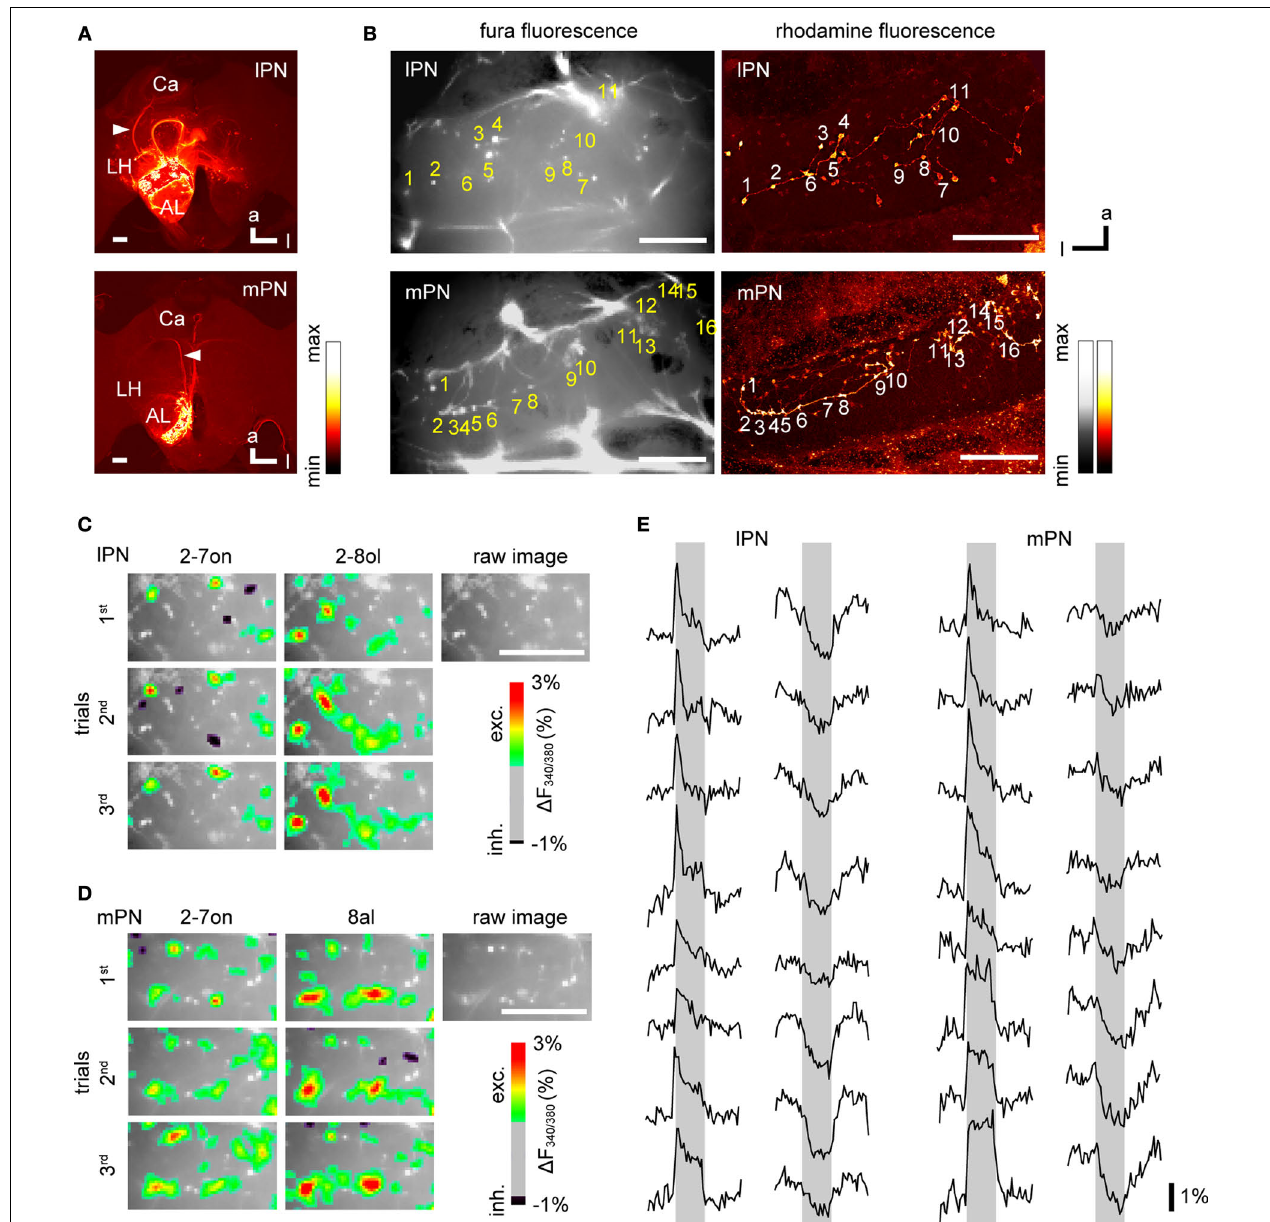
boutons are identical between images. Scale bars = 50 µm. Trial-invariant odor specifi c Ca 2 + signals in lPN (C) and mPN (D) boutons. Raw fl uorescence images are superimposed on color-coded Ca 2 + responses of boutons. Locations of isolated activity spots and individual boutons (bright spots) match. 2-7on: 2- heptanone; 2-8ol: 2-octanol; 8al: octanal. Scale bars = 50 µm. (E) lPN and mPN boutons exhibited both excitatory and inhibitory responses. Response traces give Δ F ; gray bars indicate the 3s-odor stimulus. Vertical scale bar: 1% in Δ F 340/380